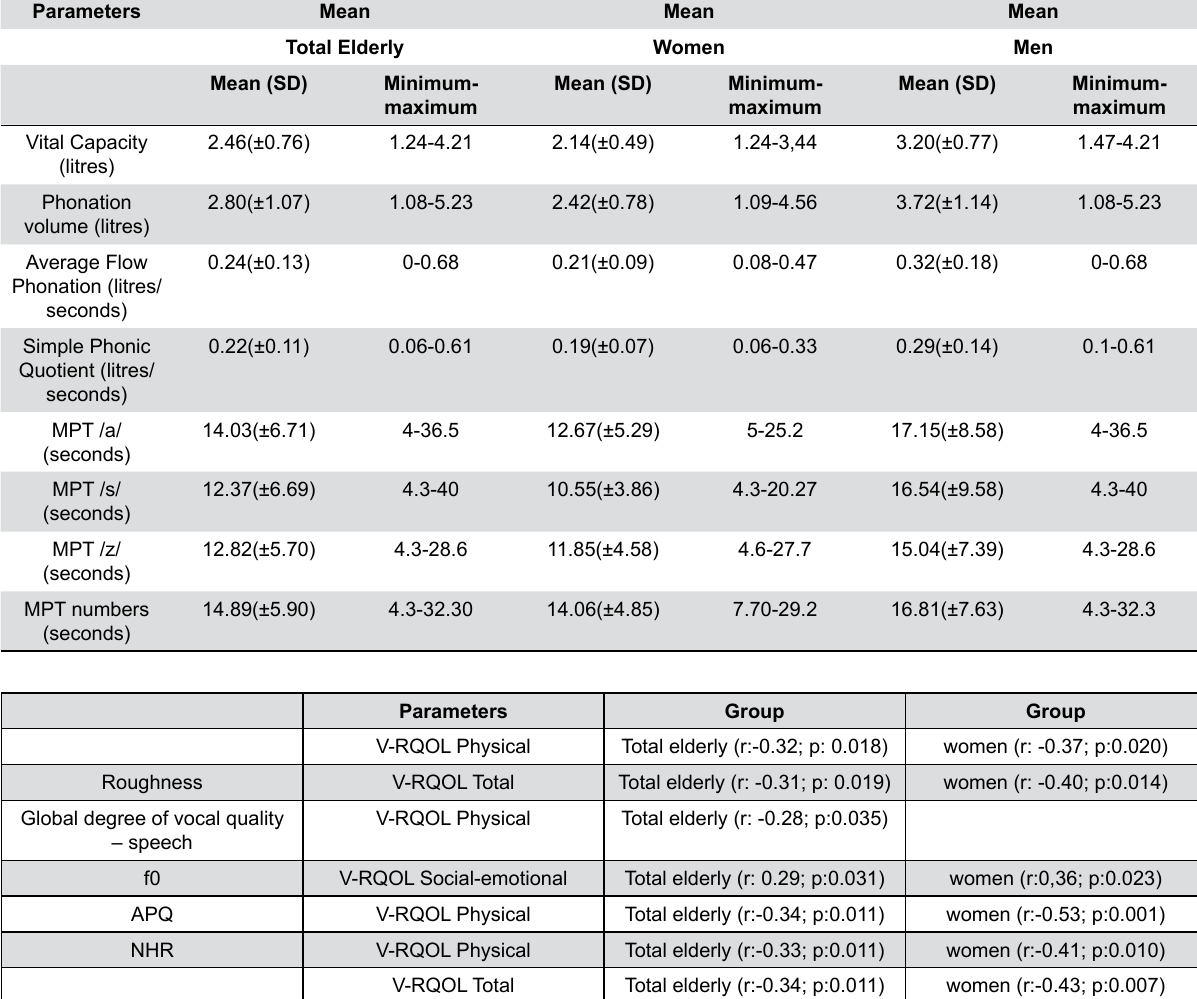
Table 3- Values of respiratory parameters of men and women elderly